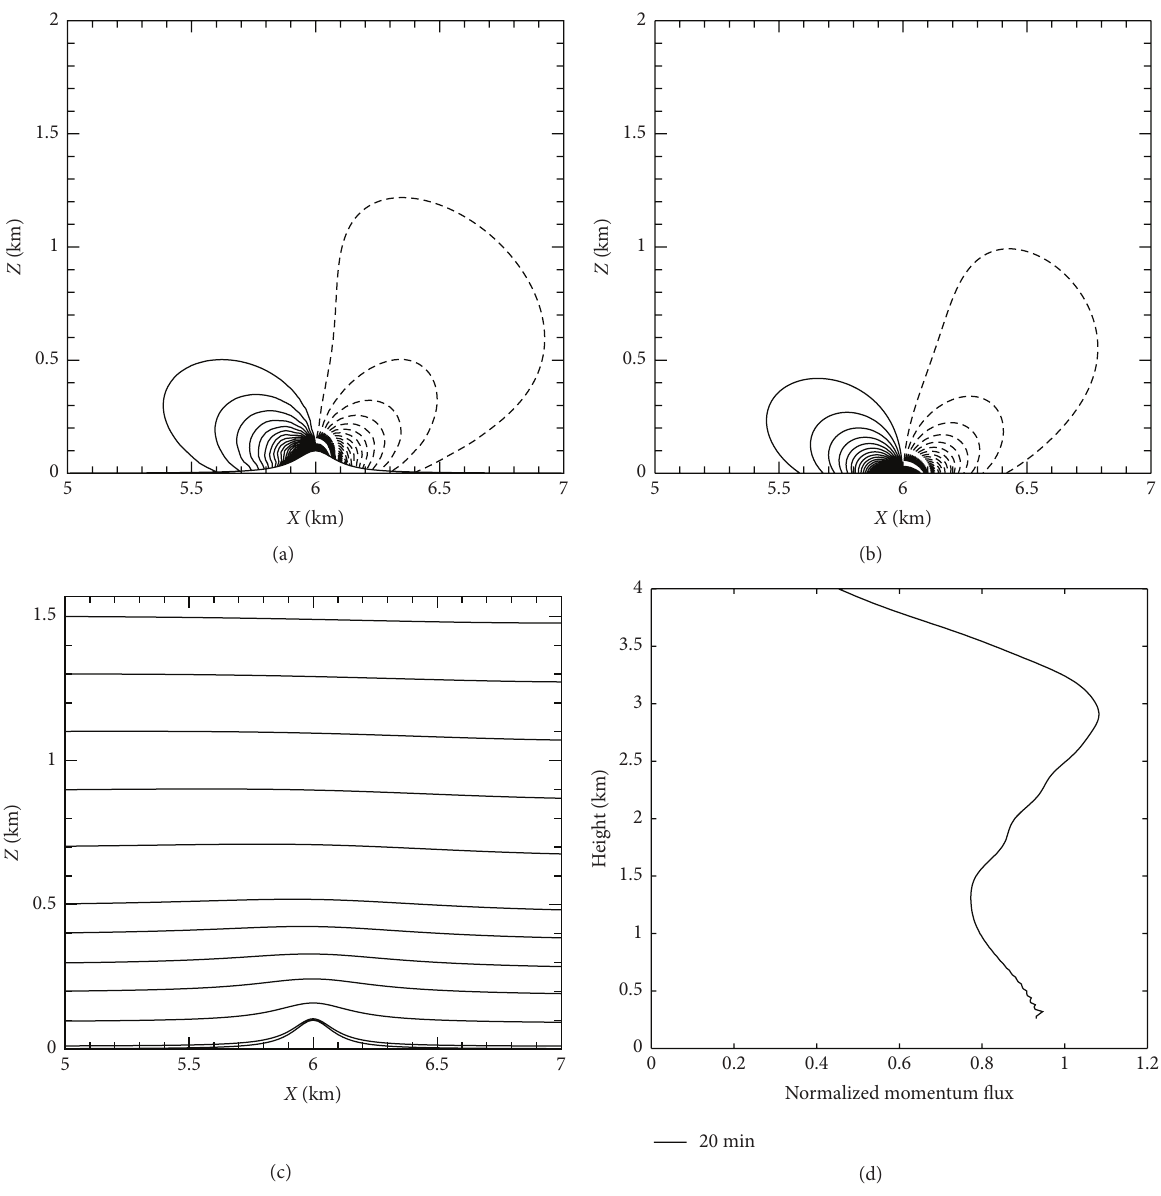
Figure 3: Numerical results of case A3. Numerical solution (a), semianalytic solution (b), streamlines from 0 to half vertical wavelength height over an isolated mountain (c), and normalized momentum flux (d) are shown. Contour interval is 0.25 ms −1 . All negative values are denoted by dashed